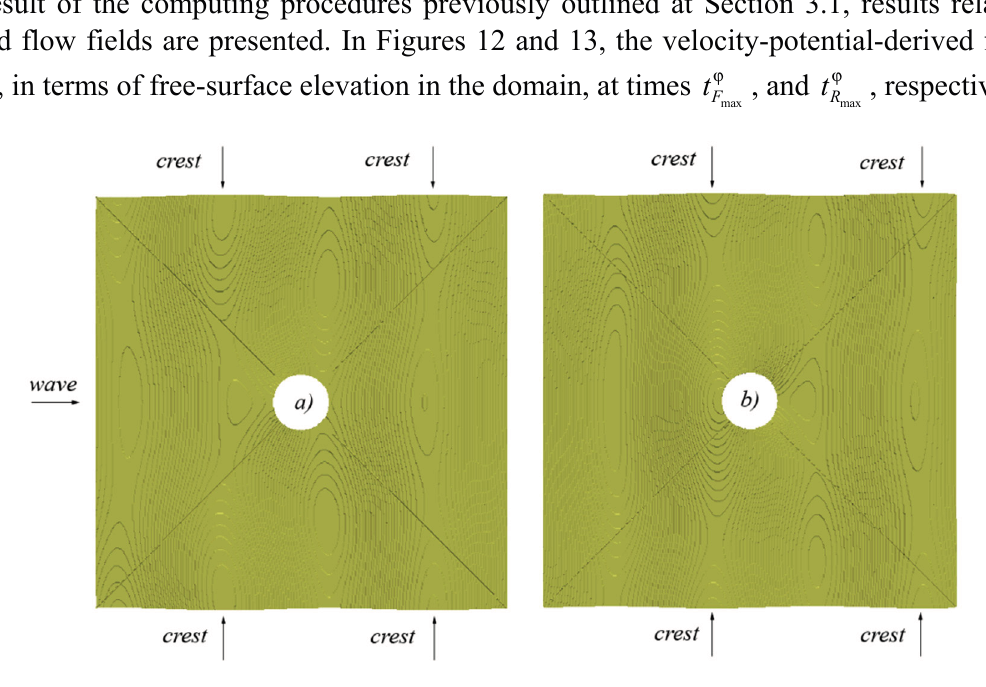
nd R ) on cylinder as a function of Figure 11. Runup ( max Fuchs [1]; ( ♦♦ ) data from solution of Euler equations; ( ●● ) data from solution of